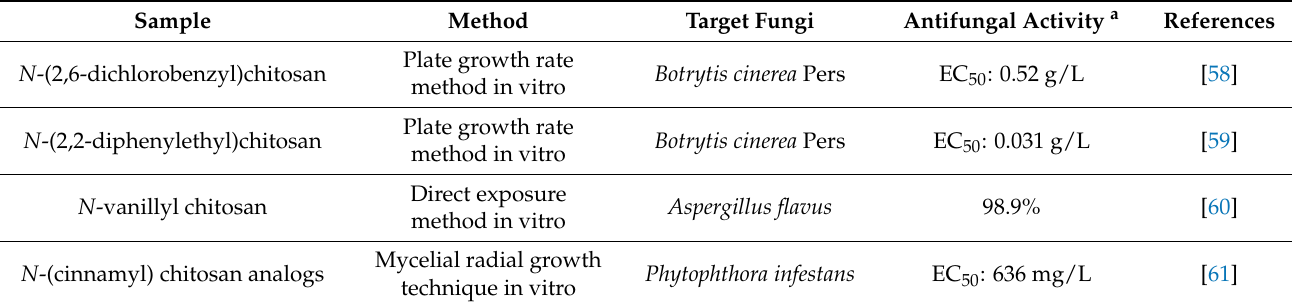
Table 6. Antifungal properties of some alkylated chitosan